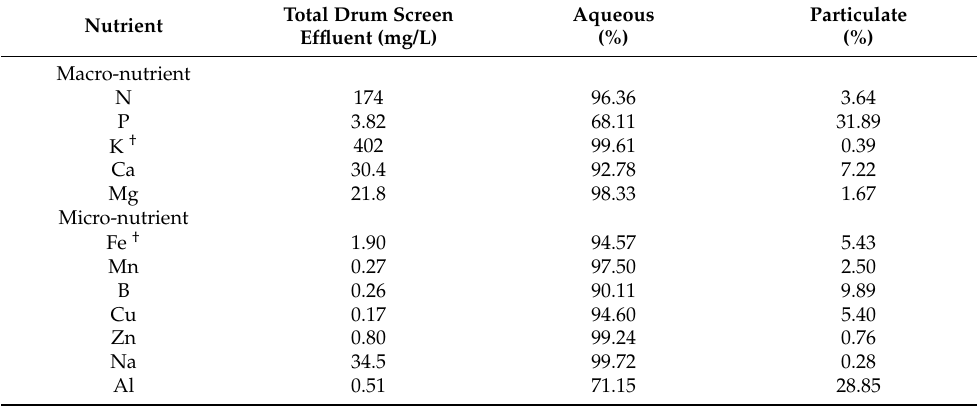
Table 1. Total nutrient concentrations in the drum screen effluent collected from UNH KFRAG as a combination of the aqueous and particulate nutrient mass normalized to 1 L of effluent. The aqueous and particulate mass fractions for each nutrient are expressed as a percent of total mass. Nutrients found in the aqueous fraction were considered plant available.